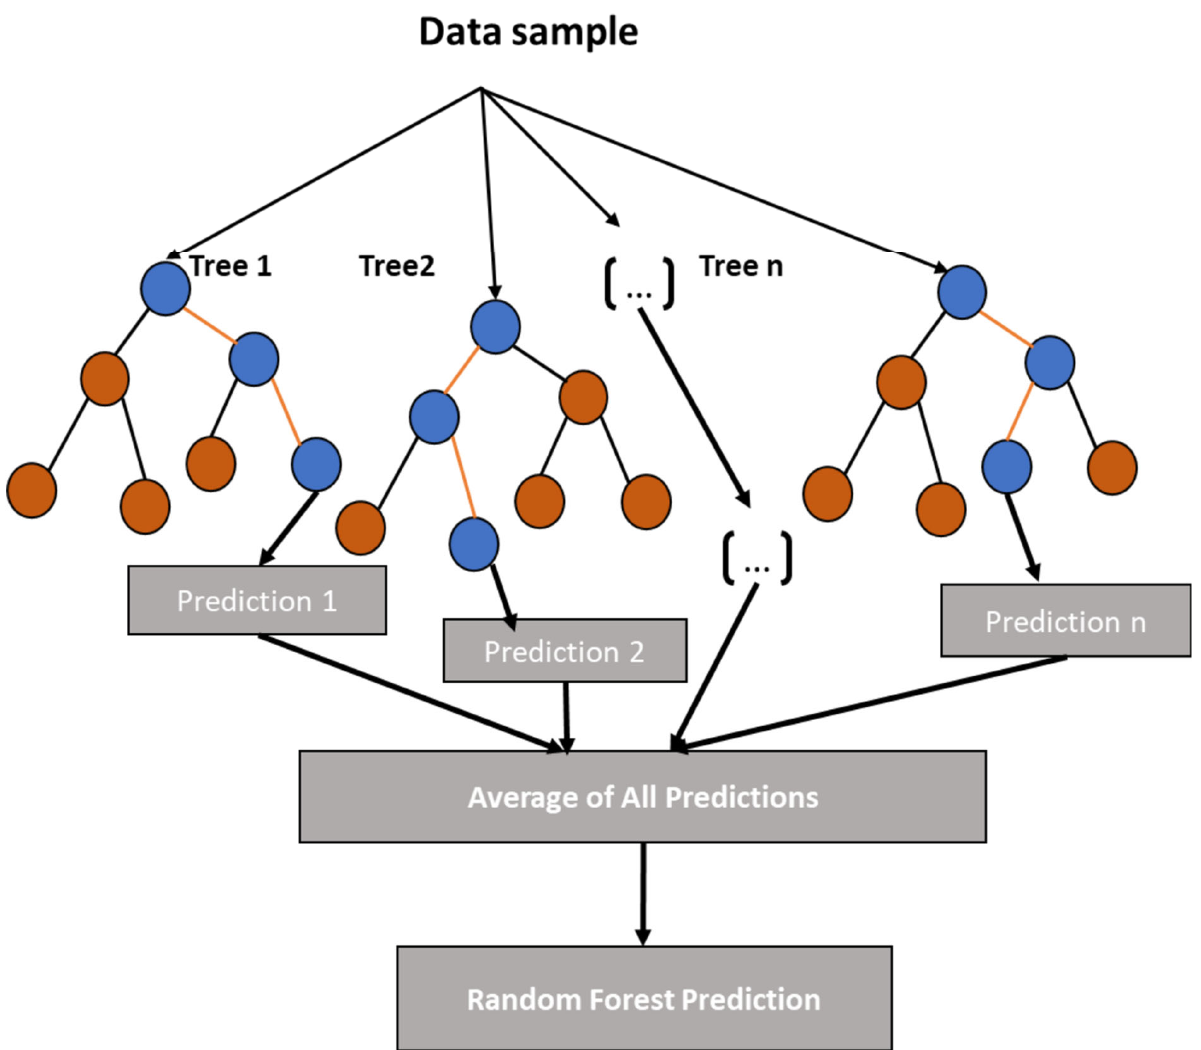
Figure A3. Random Forest schematic showing, an ensemble of decision tree predictor and the average prediction defines the final output model. Table A3. Description of final optimized parameters for random forest ensemble learning.